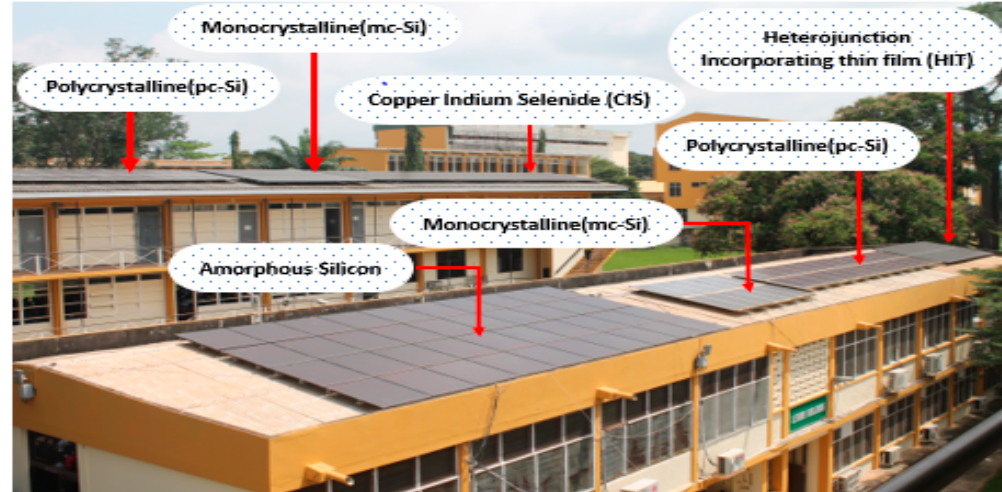
Figure 1. Outdoor monitoring set ‐ up at College of Engineering KNUST, Kumasi, Ghana.